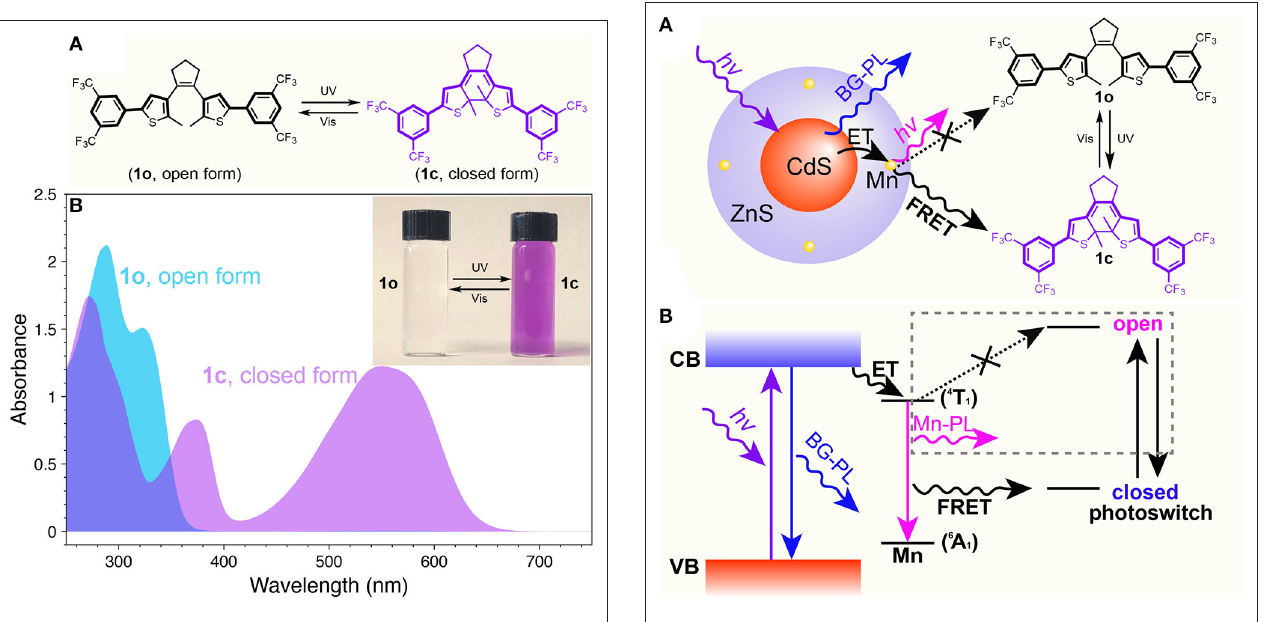
FIGURE 2 | Scheme (A) and energy diagram (B) of proposed mechanism for the selective Mn-PL quenching between Mn-doped CdS-ZnS core-shell QDs and diarylethene 1